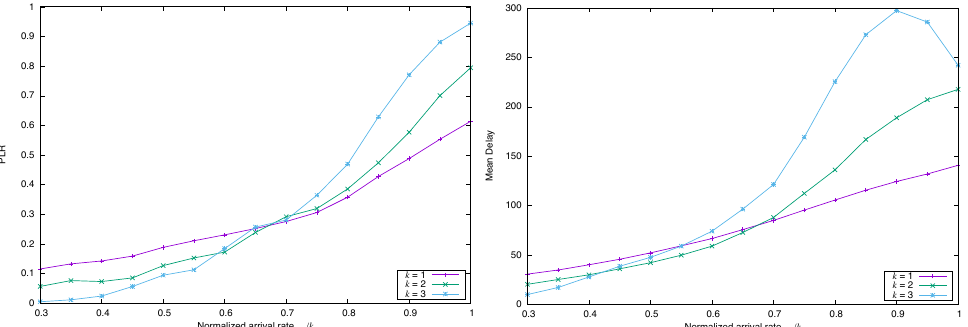
Figure 14. Simulated PLR ( left ) and Mean Delay ( right ) for FA-CSA versus λ a / k , with Λ ( x ) = 0.86 x 3 + 0.14 x 8 , n = 200 and k = { 1,2,3 } , and correlated arrivals ( H = 0.75 and r 1 = 0.9) with marginal Poissonian distribution.